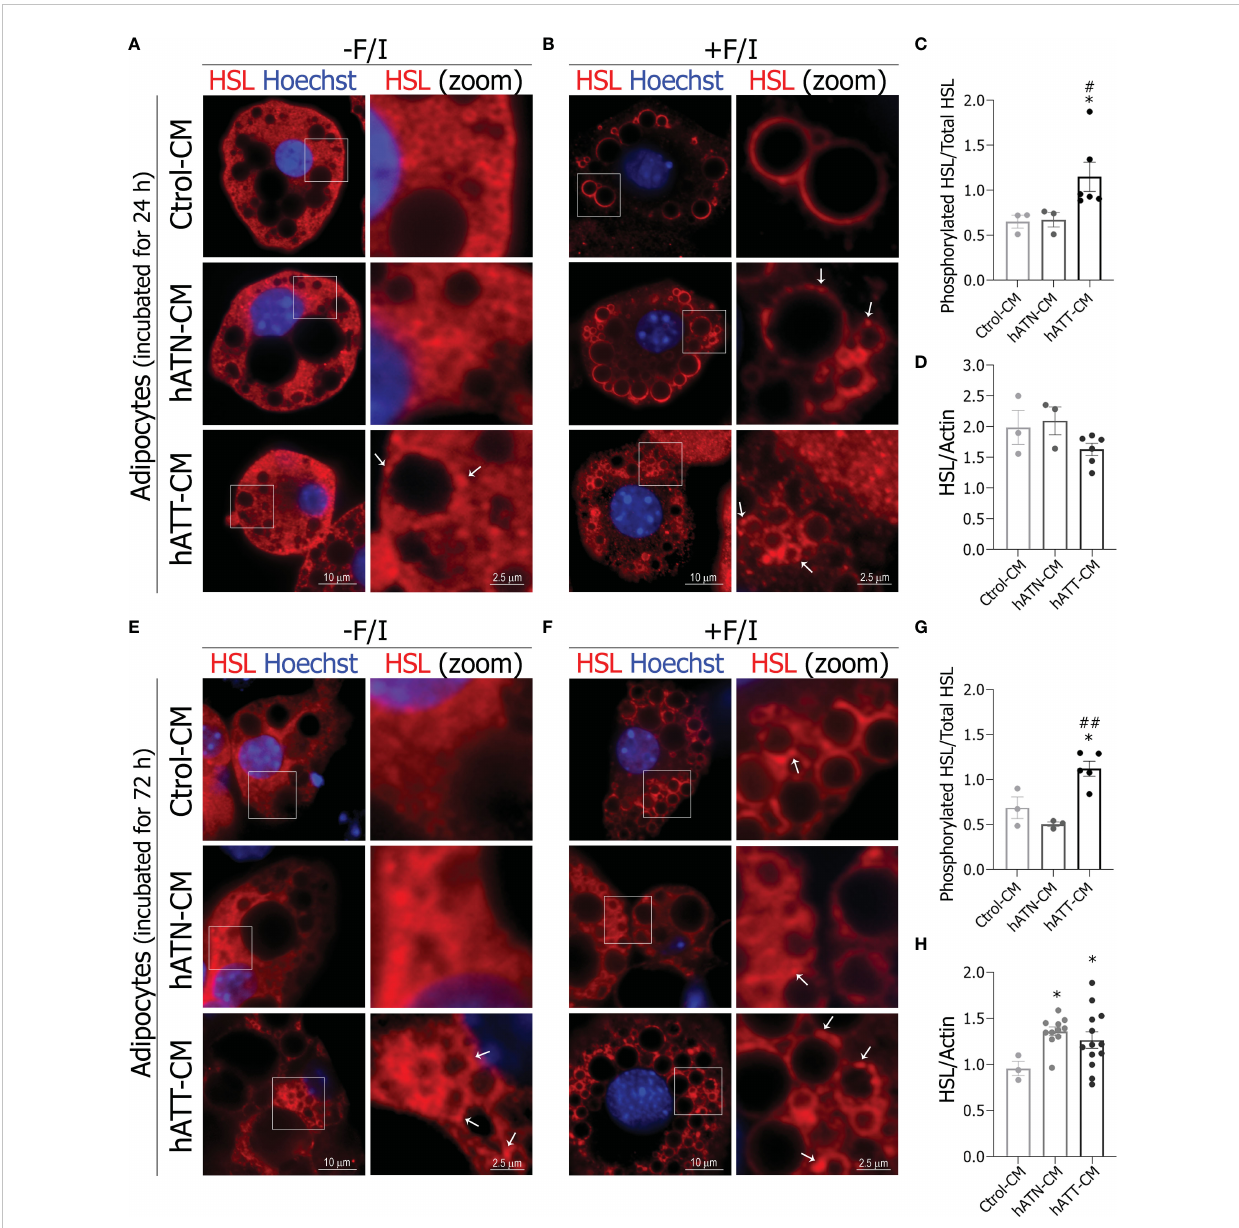
FIGURE 8 Effect of CM from hATN and hATT on localization/protein expression of HSL in mature adipocytes. 3T3-L1 adipocytes were incubated with hATN-, hATT- or Ctrol-CM for 24 h (A, B) and 72 h (E, F) followed by incubation with DMSO (-F/I, basal condition) or 20 µM forskolin plus 0.5 mM IBMX (+F/I, lipolytic condition) for 15 min. Then, 3T3-L1 adipocytes were subjected to IIF with the indicated antibodies, and images were analyzed by confocal microscopy (magni fi cation x600; see Materials and methods section for further details). Boxed areas are shown as zoomed images on right: HSL (zoom). White arrows indicate domains of HSL localized on LDs. 3T3-L1 adipocytes were incubated with hATN-, hATT- or Ctrol-CM for 24 (C, D) and 72 h (G, H) , and then lysed. The Ser660 phosphorylated HSL and total HSL expression levels were analyzed by WB. Actin was used as a loading control. Images were analyzed by densitometry. (n = 3 experiments in duplicate). Student ’ s t-test with Welch´s correction was performed; *P<0.05, adipocytes incubated with hATT-CM or hATN-CM vs. Ctrol-CM; #P<0.05, and ##P<0.01, adipocytes incubated with hATT-CM vs.